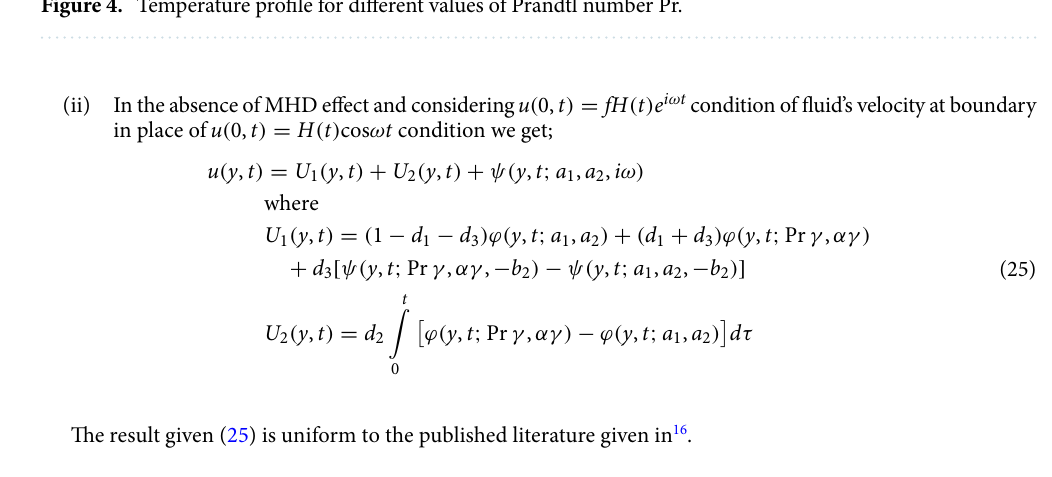
Figure 4. Temperature profile for different values of Prandtl number